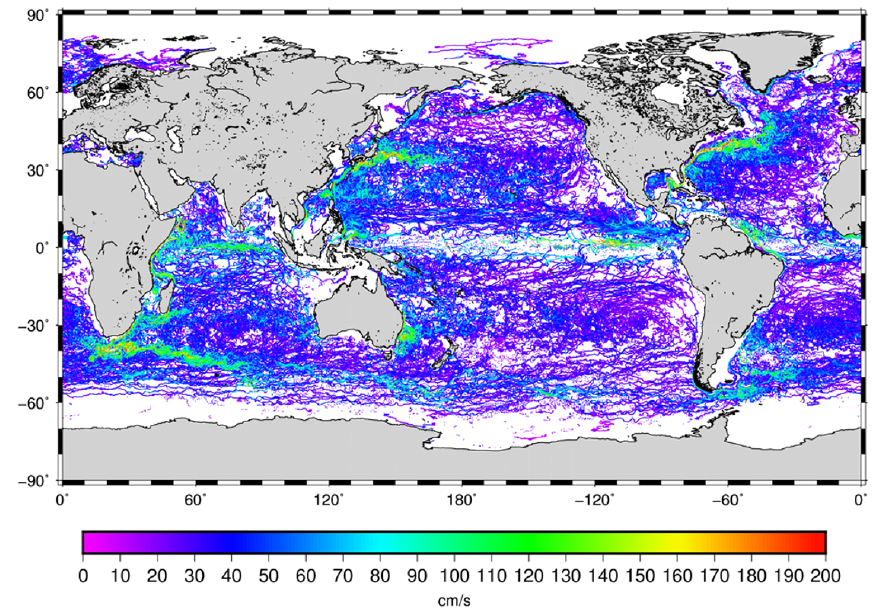
Figure 20. Trajectories of the 15m drogued SVP drifters available over the year 2017. Colors give the speed velocities deduced along the drifter trajectories.